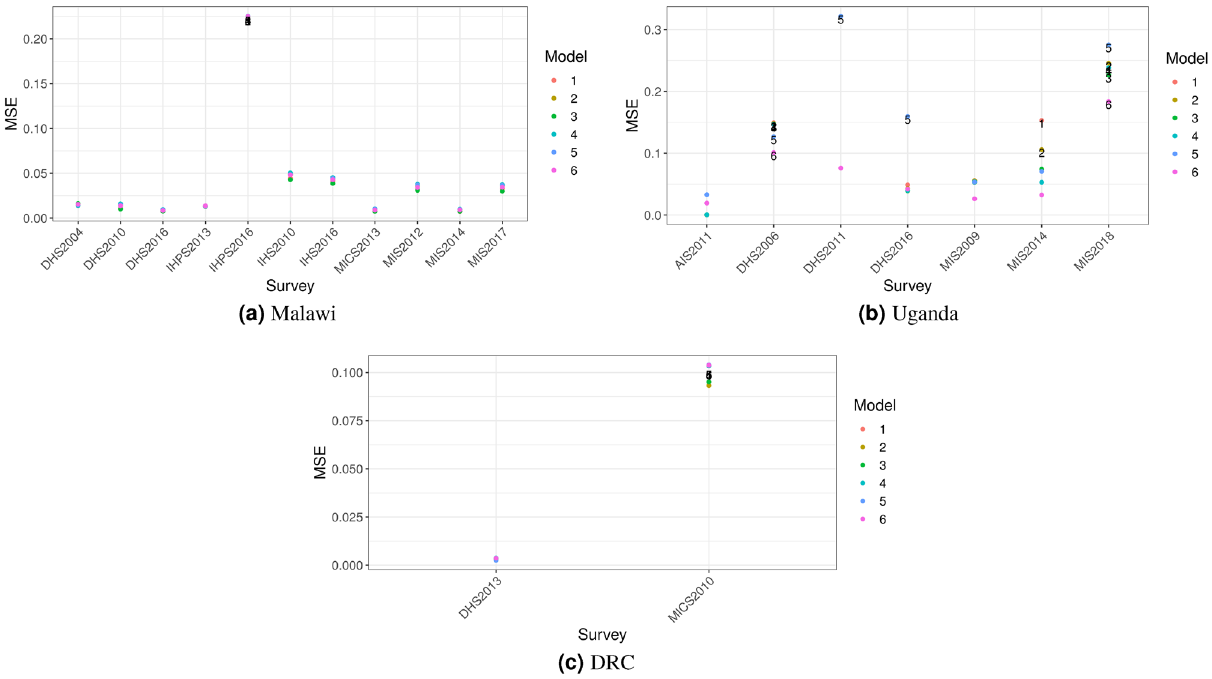
Figure 3. Leave one out cross validation results. Models with mean squared error (MSE) > 0.1 are labeled. Removed from figures (but not MSE calculations) for interpretablity: ( a ) Malawi: 2004 Integrated Household Survey, all models; Uganda ( b ): 2009 National Panel Survey (NPS), all models, 2011 DHS, models 1-2, 2010 NPS, models 1 and 3-6, and 2011 NPS, models 1-3 and 5.